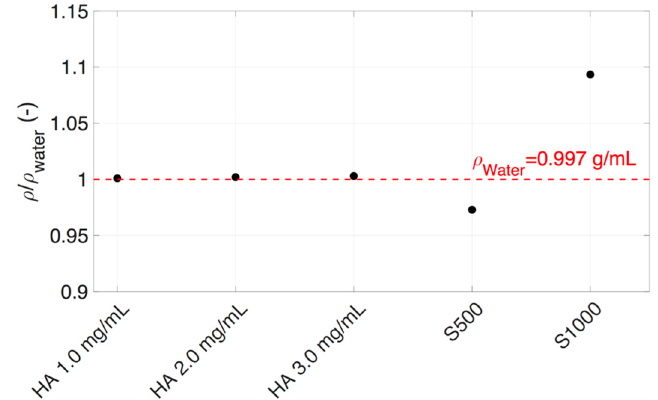
Figure 6. Density ratio of HA (1.0–3.0 mg/mL), SO (S500 and S1000), and (red dotted line) water at 25